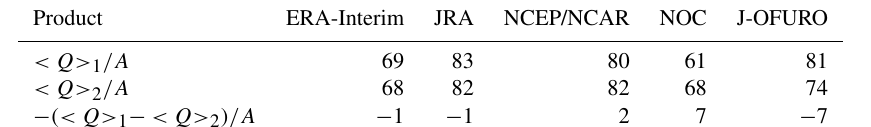
Table 1. Net surface heat flux Q (Wm − 2 ), defined positive upwards, averaged over the AW area (defined in Fig. 1) for the first period 1993–2002 ( < > 1 ) and the second period 2004–2013 ( < > 2 ). The AW area loses heat to the atmosphere in an annual mean. Five different products of surface heat flux are used, as follows: ERA-Interim (reanalysis), JRA-55 (reanalysis), NCEP/NCAR (reanalysis), NOC (in situ observations) and J-OFURO3 (satellite observations). See also Fig. 5.